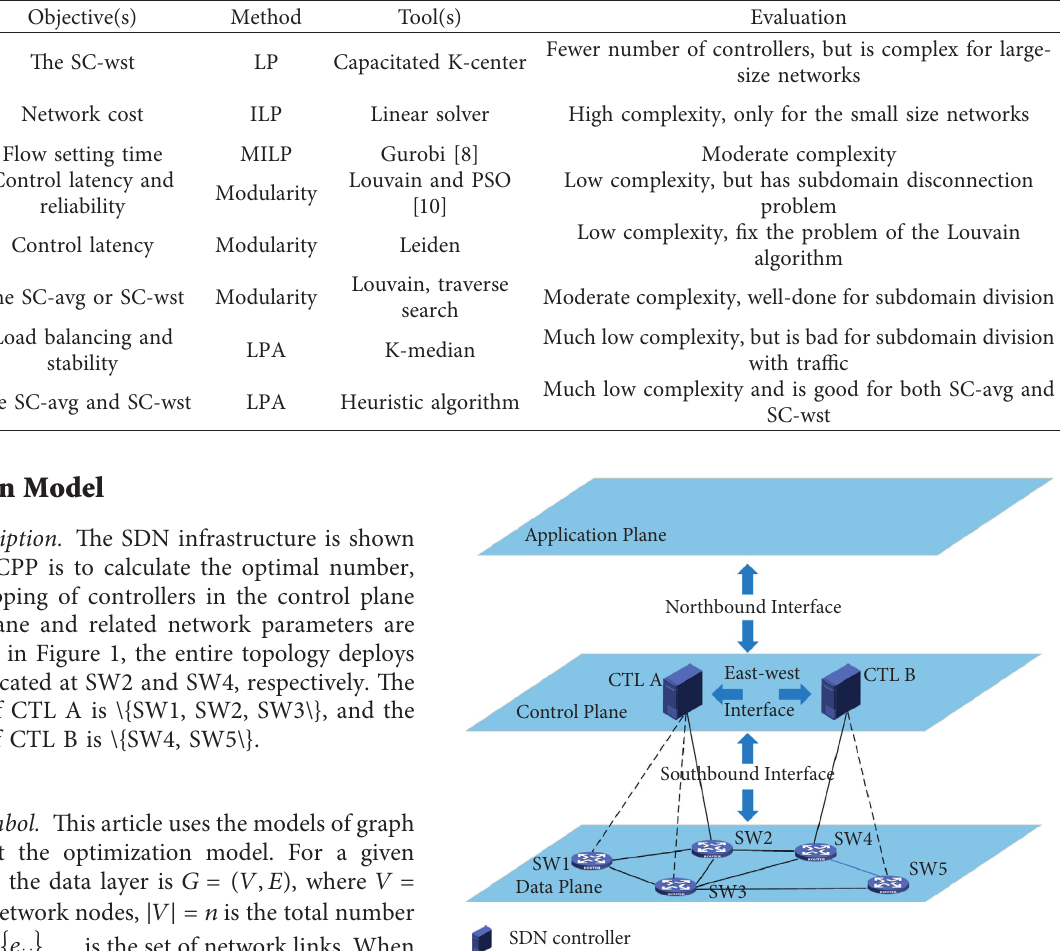
Table 1: An overview of current controller placement approaches and the proposed approach.